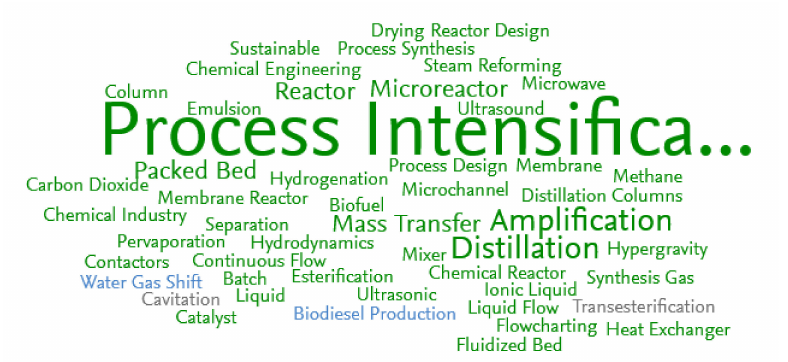
Figure 2. Scival Analysis trends obtained using Process Intensification as